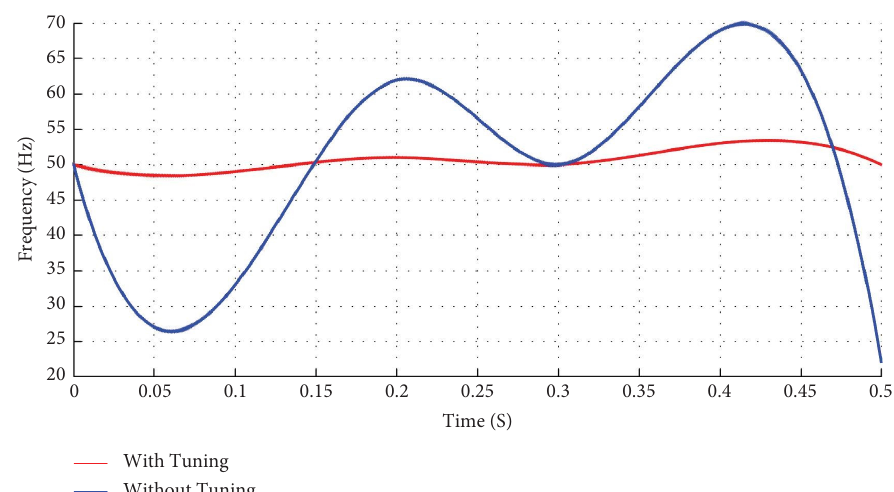
Figure 6: Frequency